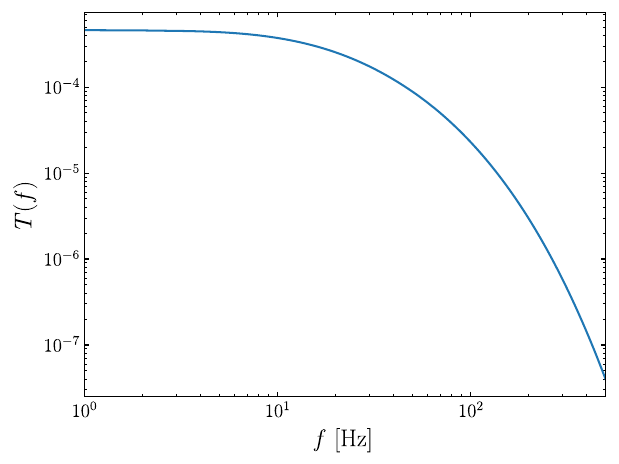
FIG. 10. Transfer function of a mu-metal cylinder with 1 mm thickness and inner radius of 1 cm T ð f Þ vs frequency f .